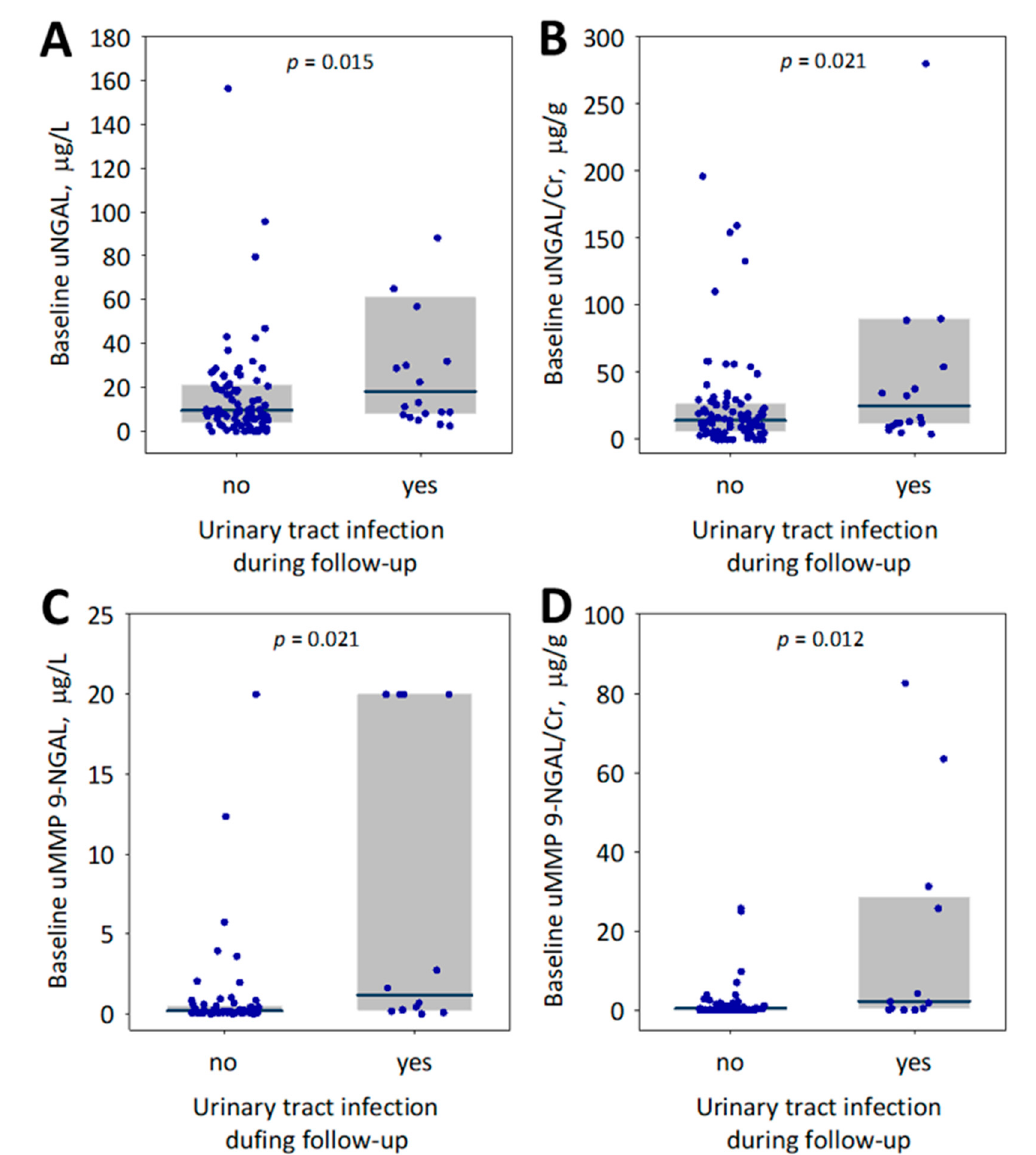
Figure 3. Baseline urine NGAL concentration (uNGAL; ( A )), urine NGAL to creatinine ratio (uNGAL/Cr; ( B )), urine MMP 9 ‐ NGAL complex concentration (uMMP 9 ‐ NGAL; ( C )) and urine MMP 9 ‐ NGAL complex to creatinine ratio (uMMP 9 ‐ NGAL/Cr; ( D )) among studied kidney transplant recipients who did or did not experience bacterial urinary tract infections during the follow ‐ up period. Data are shown as median (central line), interquartile range (box) and raw data (points); p ‐ values are given for the differences between groups. To increase readability of the graphs, we omitted the highest results of urine NGAL (528; 1275; 1401 μ g/L; panel ( A )) and NGAL/creatinine (1251; 1656; 2183 μ g/g; panel ( B )) obtained in three patients who experienced urinary tract infection during follow ‐ up.